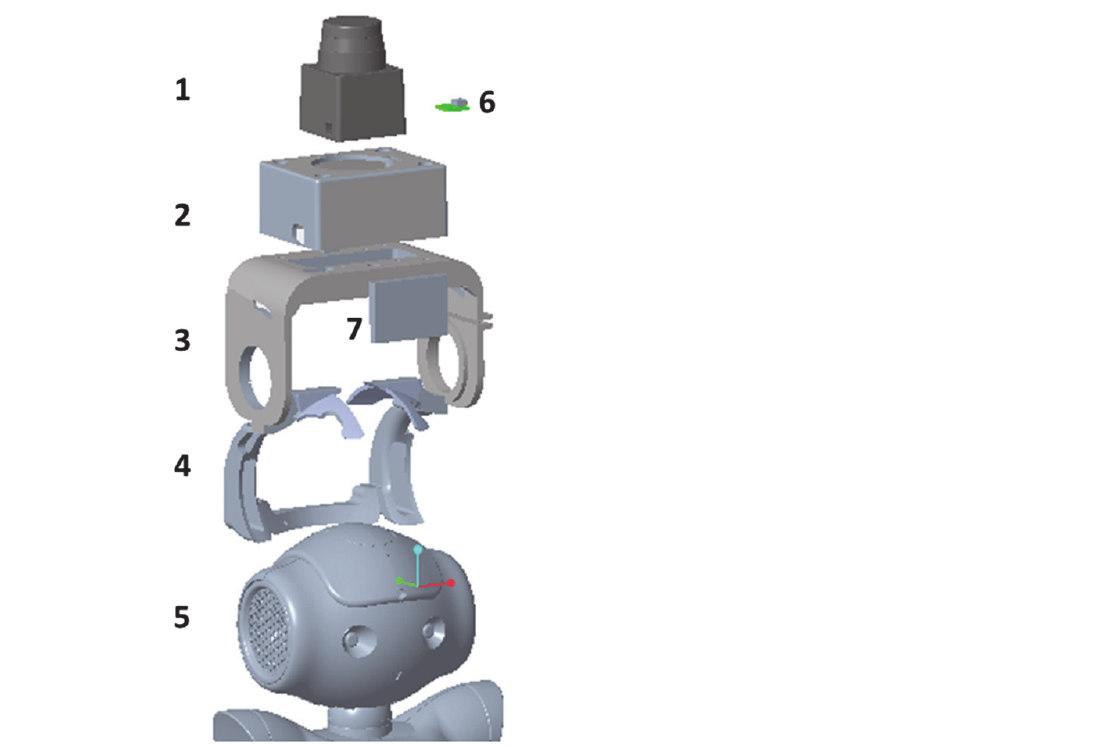
Figure 6. Exploded ‐ view drawing of the helmet’s design: (1) rangefinder laser device, (2) sensor protection enclosure, (3) payload support base, (4) rear hooking bracket, (5) robot’s head, (6) USB connector; (7) LiPo Battery.